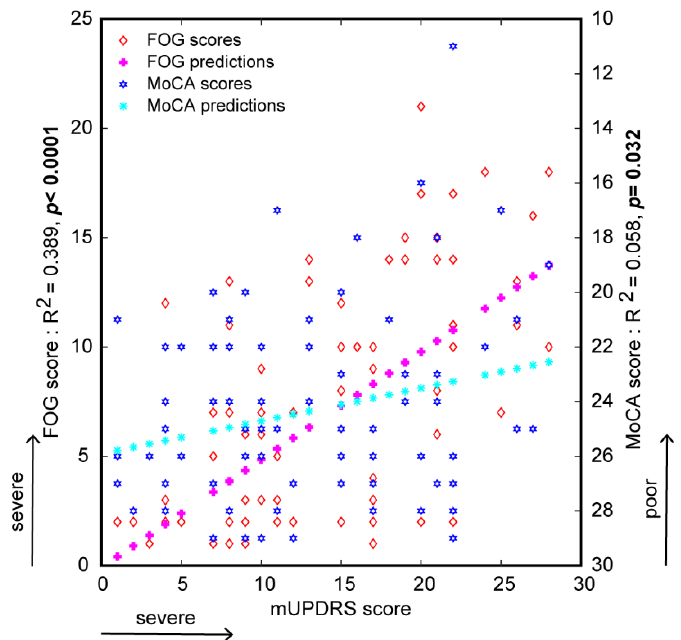
Figure 2. Linear regression analysis and predicted responses between disease severity scores and FOG severity and cognitive assessment (MoCA) scores. Bold p -values represent the significance.